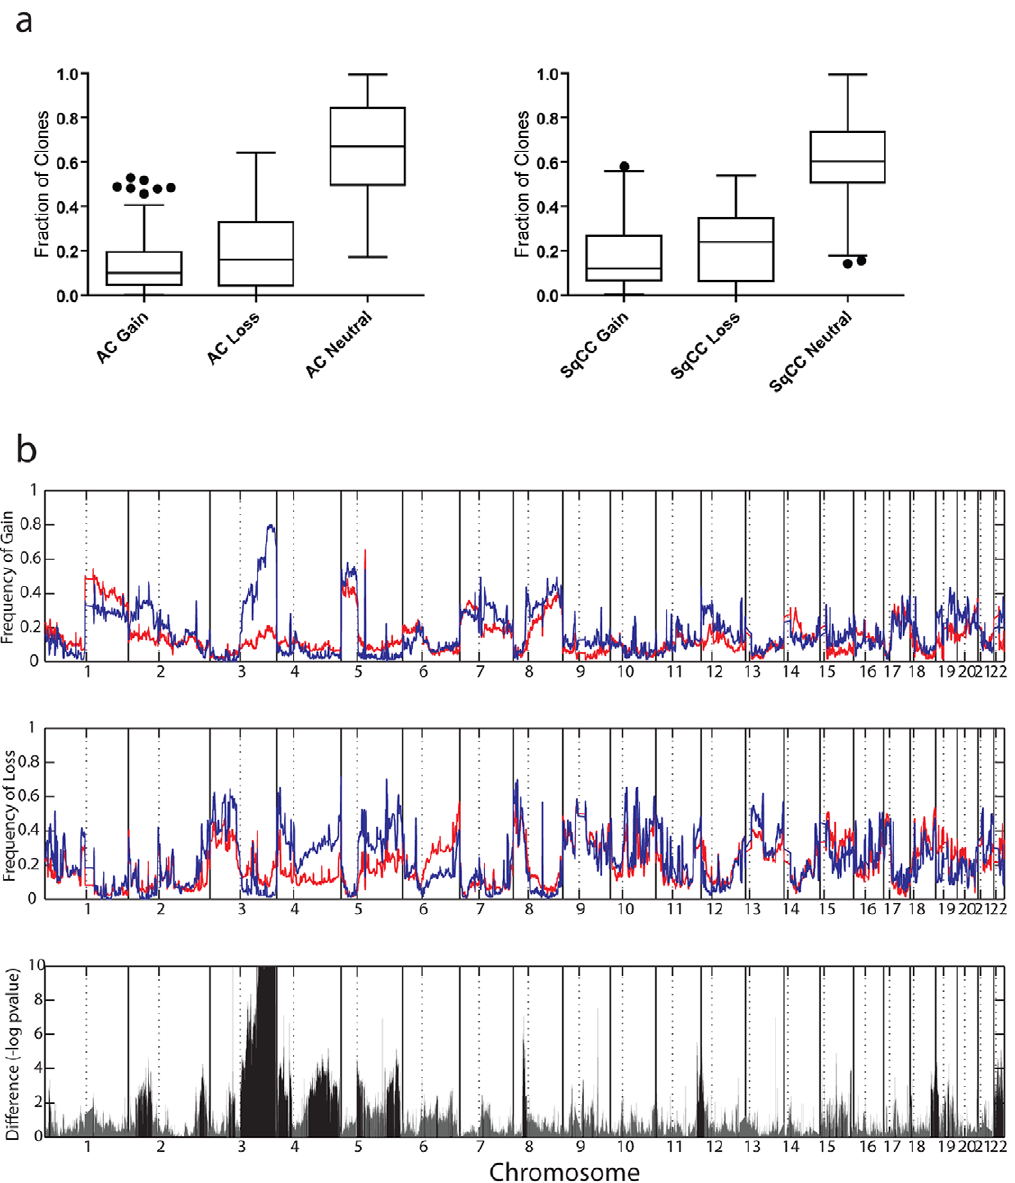
Figure 1. Genomic landscapes of lung AC and SqCC. (a) Percentage of clones of each state in both subtypes. Box plots illustrate the percentage of clones with status 2 1 (loss/deletion), 0 (neutral), and + 1 (gain/amplification) in each of the subtypes. Percentages were calculated for each sample and for each status. These plots demonstrate the similarity in total genome alteration percentages between AC and SqCC tumors and suggest that recurrently altered regions of genome are the result of selection rather than a higher frequency of gain or loss of DNA in either subtype. (b) Alteration frequencies for 169 AC (red) and 92 SqCC (blue) tumors are displayed across the entire human genome. Solid vertical black lines represent chromosome boundaries whereas the dotted black lines represent chromosome arm boundaries. The frequency of copy number gain is denoted in the top panel. Note the high frequency of 3q gain in the SqCC subtype, consistent with previous reports. Additional regions of copy- number difference are also clear, such as the more common gain of chromosome 2p in AC. The second panel (middle) shows the frequency of copy number loss. Common tumor suppressor gene loci such as chromosome 3p are common between AC and SqCC, but large differences exist in regions such as chromosome 4q. The significance of copy number disparity (inverse p-value corrected for multiple comparisons) between AC and SqCC subtypes is depicted in the third (bottom) panel. Solid black lines represent regions considered statistically different (p # 0.01) whereas grey lines are not.